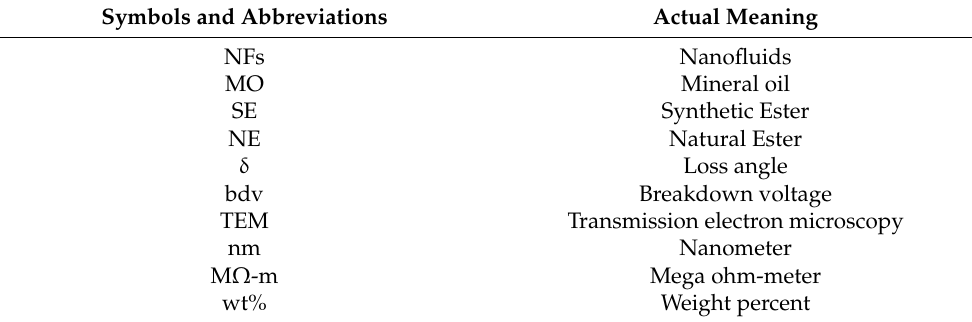
Table 3. Nomenclature